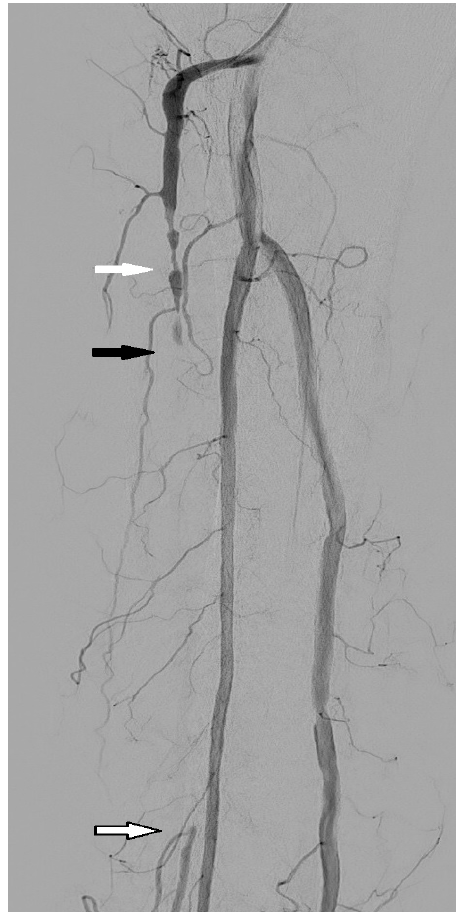
Figure 5. Multiple focal critical stenosis of proximal anterior tibial artery (white arrow) followed by segmental occlusion of the vessel (black arrow) and distal reperfusion (contoured white arrow).